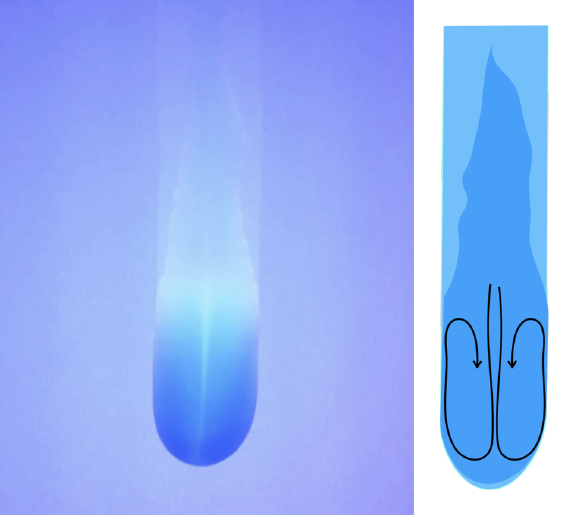
Figure 8: Close-up of a water droplet sliding along a frosted glass plate.